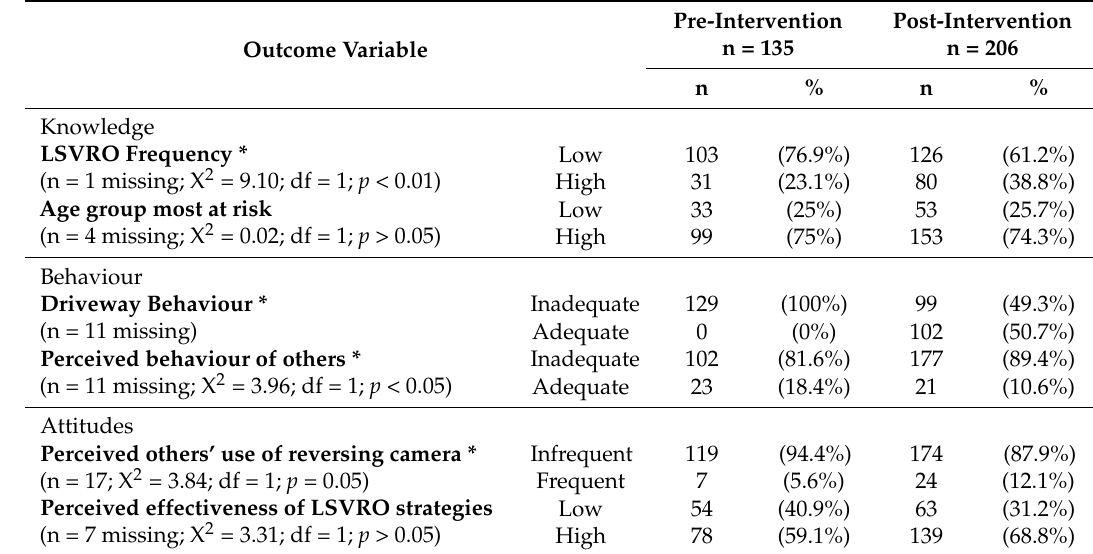
Table 2. LSVRO Knowledge, Attitudes, and